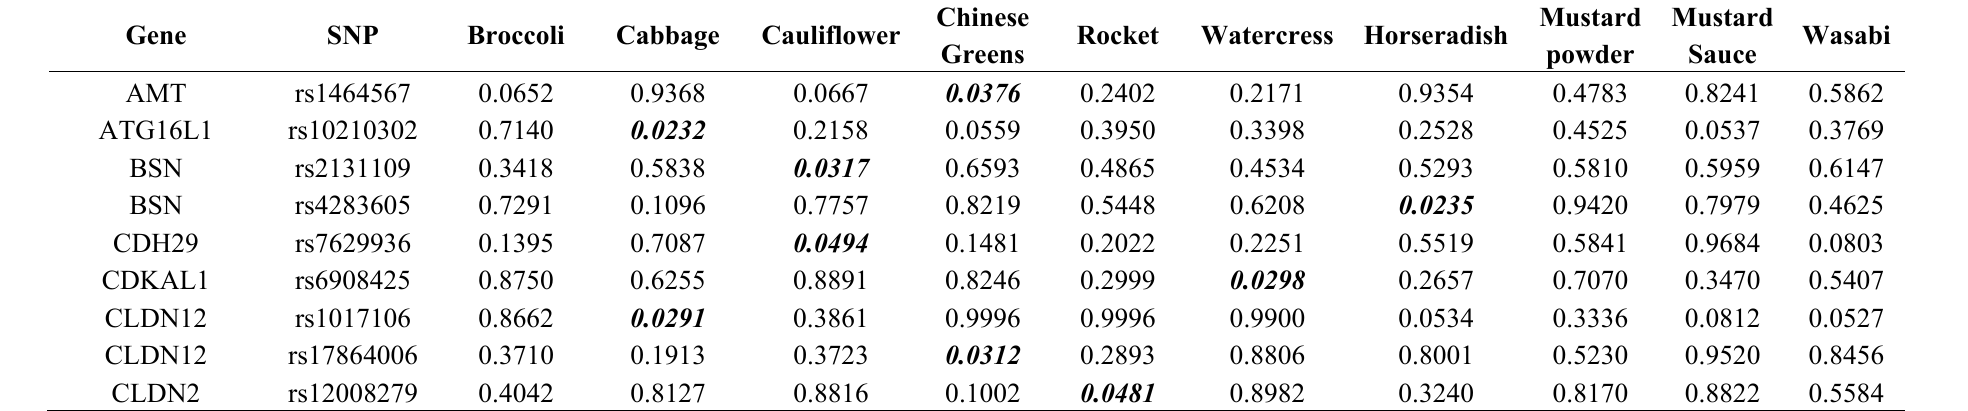
Table 4. Results of SNPs from candidate genes associated with adverse effects of Brassicaceae; showing p -values only; significant p values highlighted in italic and bold. (* Remained significant after applying multiple testing correction using false discovery